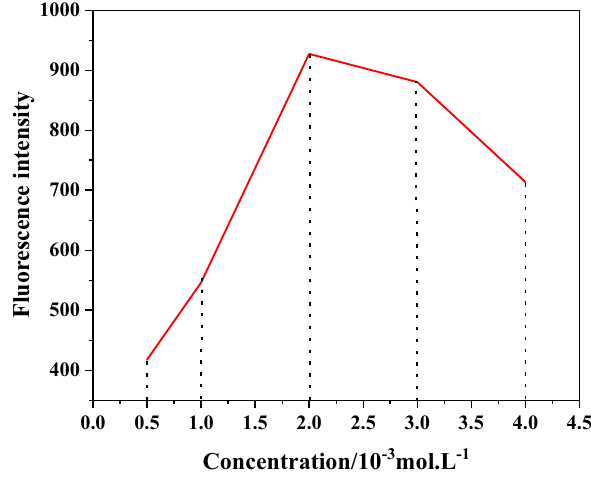
Figure 4: E ff ect of Bpy concentration on the maximum fl uorescence intensity of the system.